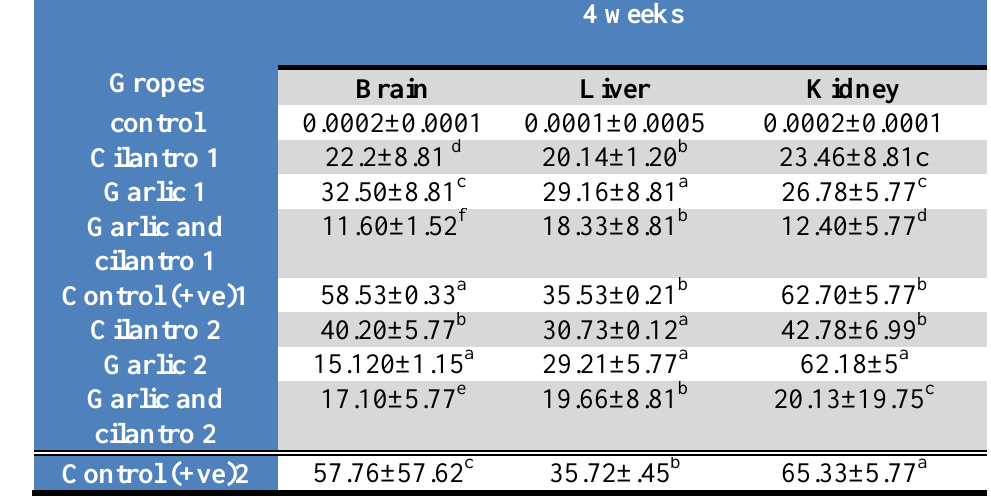
Different small letters means significant ( p <0.01) results between